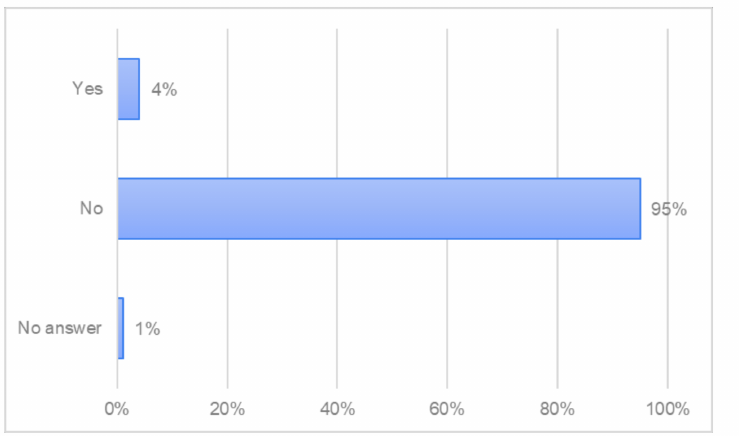
Figure 15. Summary of injuries that happened to tree climbers due to the incident with electric line.